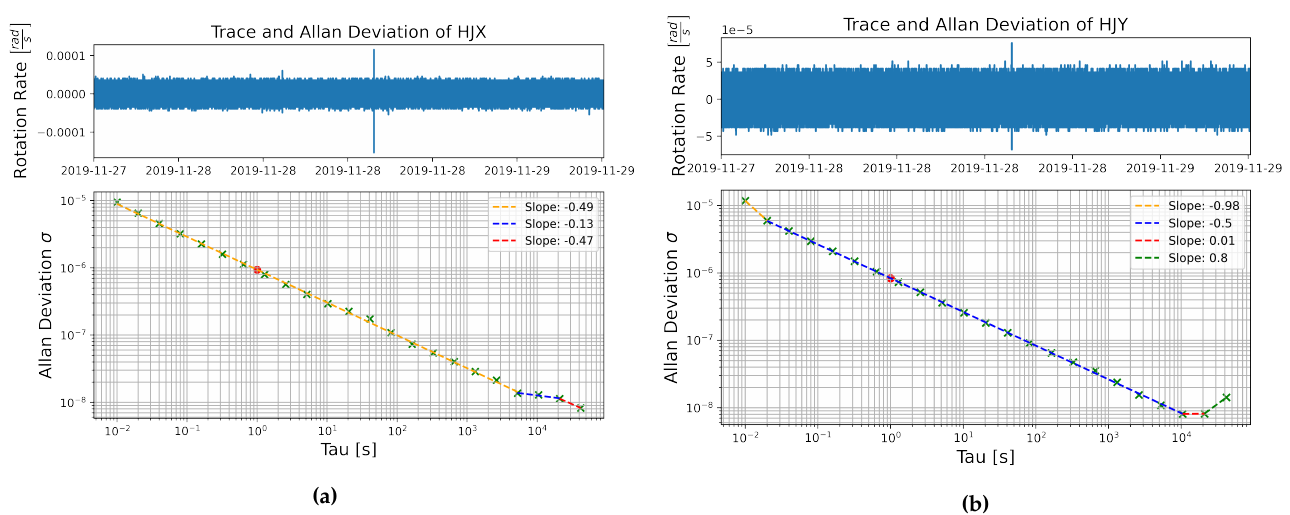
Figure 5. Allan deviation as a function of averaging time τ for self-noise recorded on the FOG rotation components ( a ) HJX and ( b ) HJY, data recorded in the basement test site between 27 November and 28 November 2019.